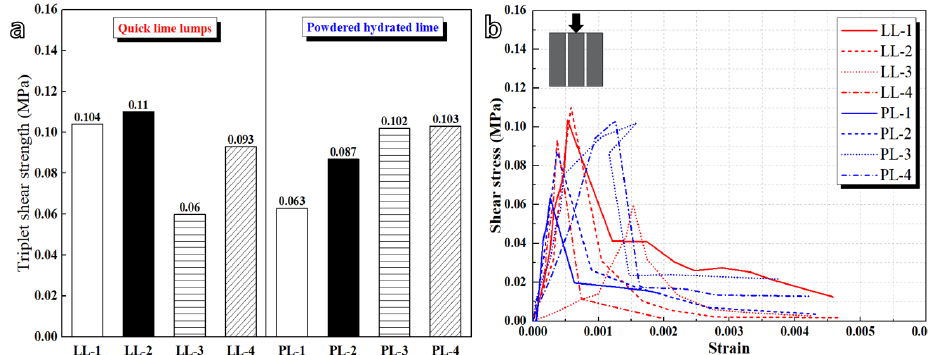
Figure 17. Triplet test results. ( a ) Triple shear strength ( b ) strain–stress curve.